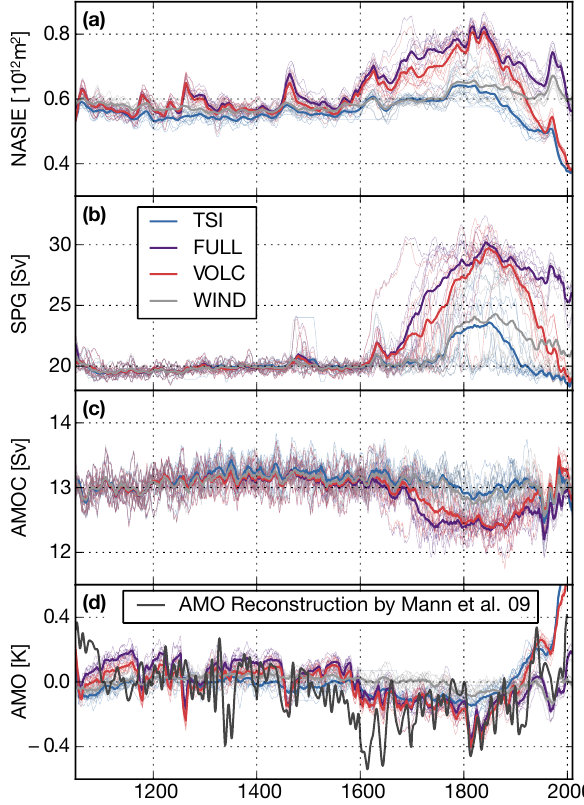
Fig. 3. To identify the driving processes behind SPG and AMOC dynamics, the different forcings applied are treated separately (bold: ensemble mean, light: individual members). Pure prescribed wind forcing (WIND) is shown in grey, wind plus changes in the solar irradiance only (TSI) in blue, wind plus volcanic forcing in red (VOLC) and the combination of all forcings (FULL) in purple. An- thropogenic CO 2 is applied in TSI, VOLC and FULL. (a) NASIE, (b) SPG, (c) AMOC and (d) AMO anomalies in comparison with the reconstruction time series by Mann et al. (2009).